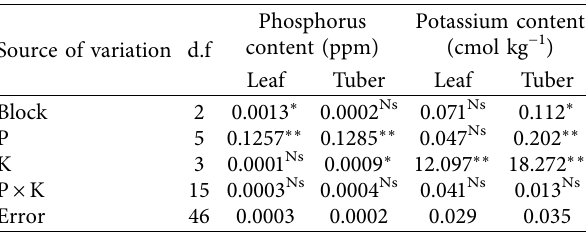
where ∗∗ , ∗ � indicate a signifcant diference at 1% and 5% level of sig- nifcance, respectively; Ns � nonsignifcance at 5% level of signifcance; d.f � degree of freedom; P � phosphorus (P 2 O 5 ); and K � potassium (K 2